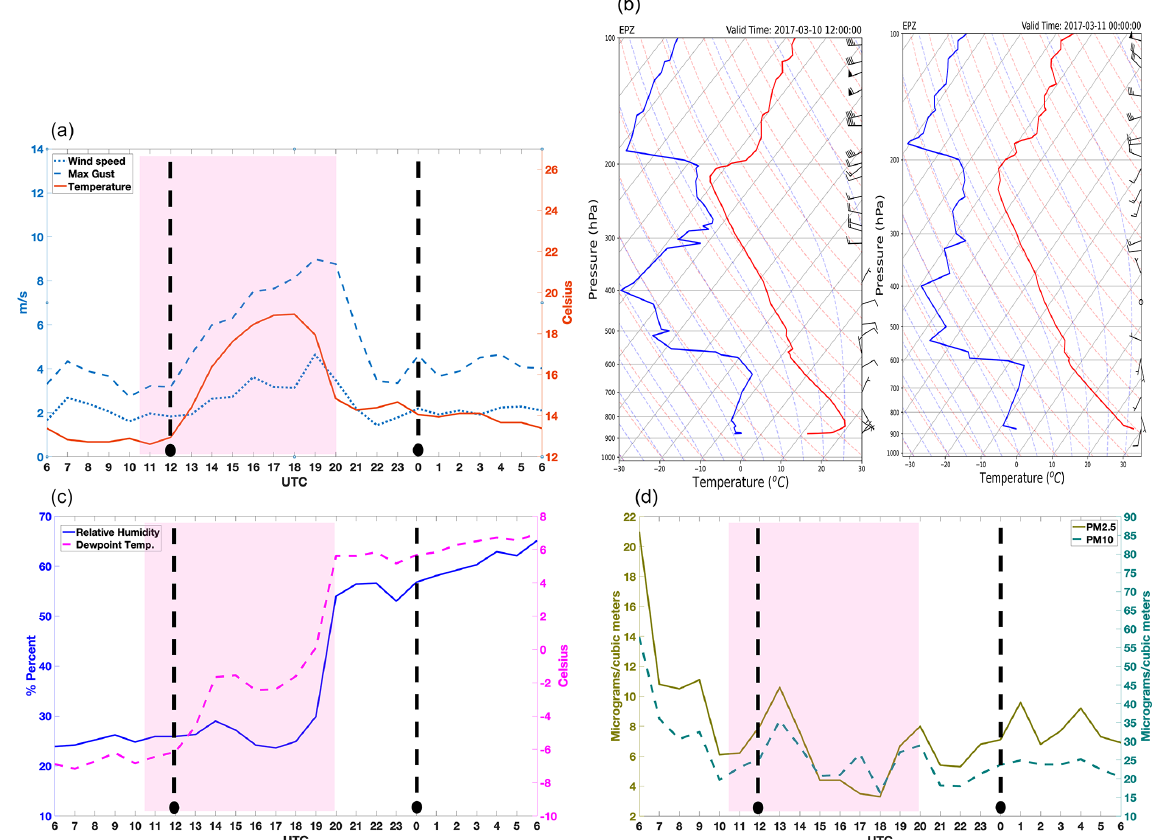
Figure 8. Hourly surface measurements in UTC from the CAMS 12 at UTEP for 10–11 March 2019. (a) Wind speed (dotted blue), maximum wind gust (dashed blue; ms − 1 ), and surface temperature (red; ◦ C). (b) Sounding along with wind barbs from NWS for 10 March 2017 at 12:00UTC and 11 March 2017 at 00:00UTC ( T d in blue; T in red). (c) Relative humidity (purple) and dew point temperature (dashed pink). (d) PM 2 . 5 concentration (olive) and PM 10 concentration (dashed teal). Shaded portions represent the virga event, and dashed black lines and dots represent the availability of radiosonde